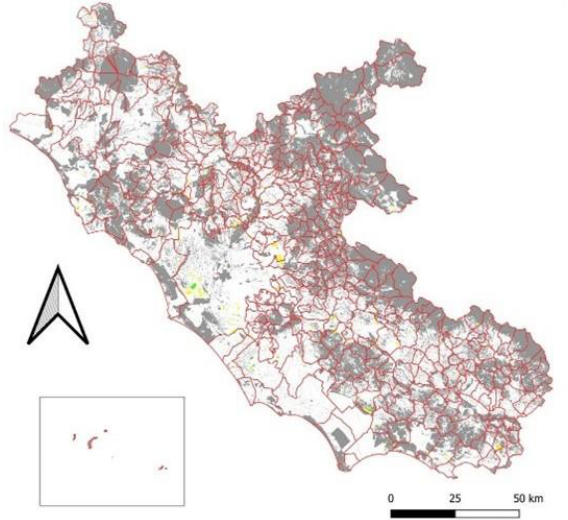
Figure 5 . Map with 'Landfills’ (green) and ‘Quarries' (yellow), in grey all unsuitable areas; red lines are municipalities